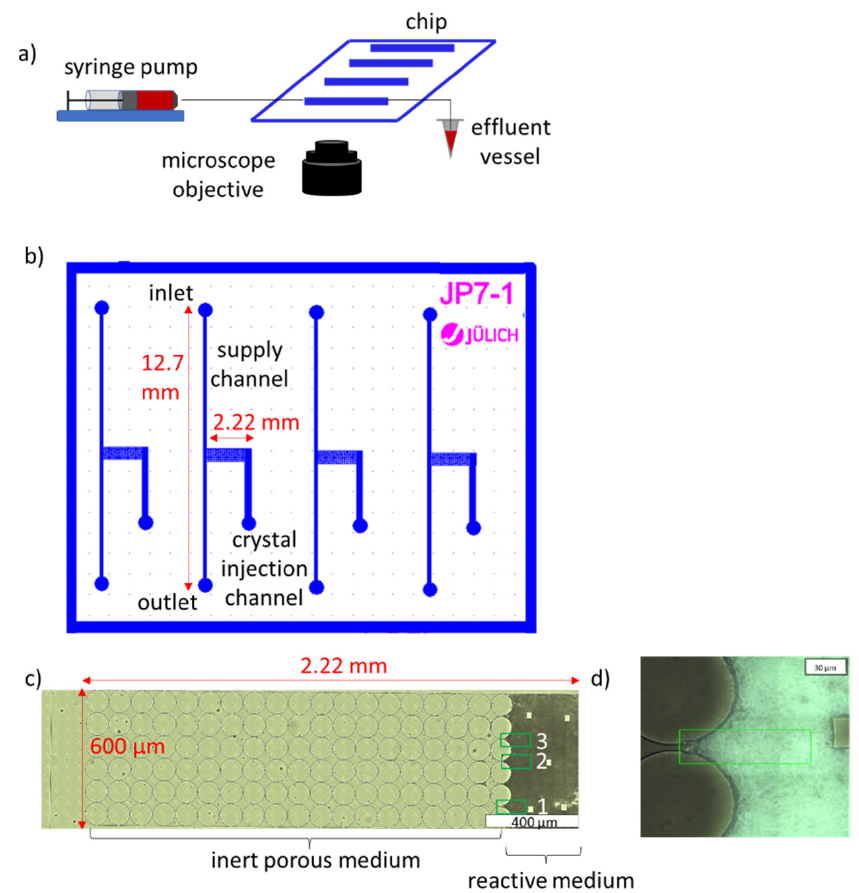
Figure 1. ( a ) Experimental setup; ( b ) chip design with ( c ) a zoom on the inert porous medium and ( d ) the reactive porous medium.